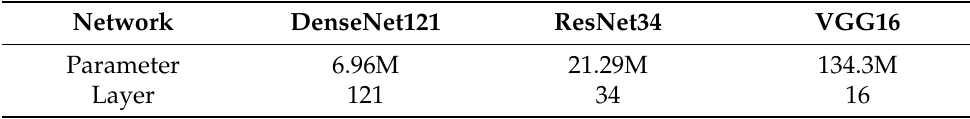
Table 5. Structure details of DenseNet121, ResNet34, and VGG16.